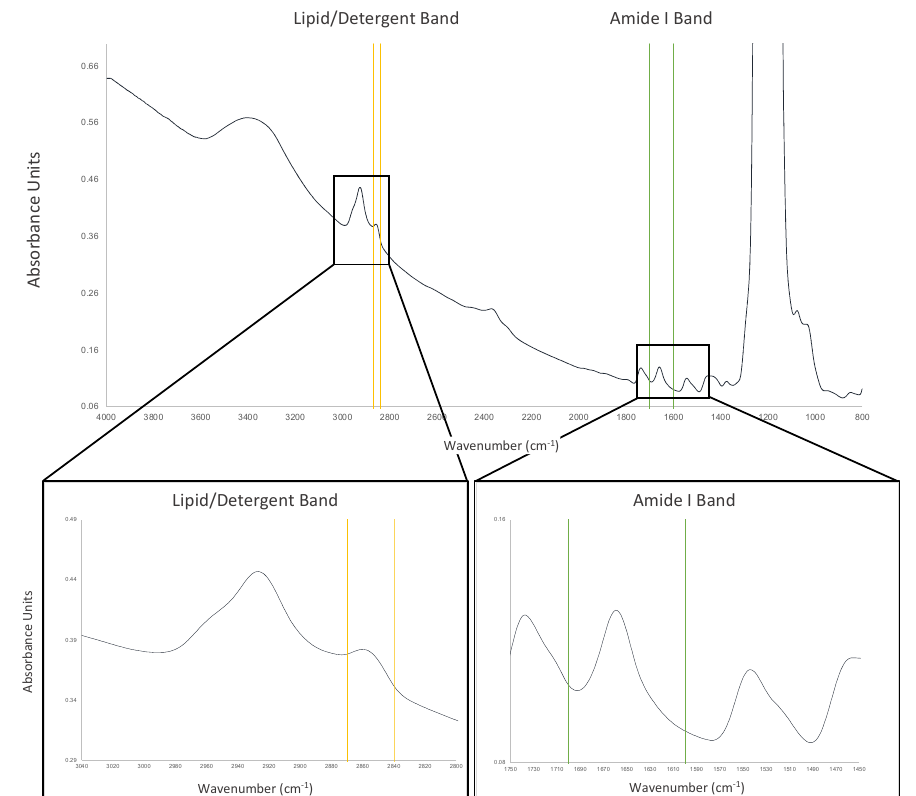
Figure 9. Mid-infrared spectrum of a membrane protein in n-Dodecyl- β - d -Maltopyranoside (DDM). Measurements were performed using the direct detect spectrometer (EMD Millipore). The protein sample (2 µ L) was blotted onto a hydrophilic polytetrafluoroethylene (PTFE) membrane and dried for 30 s using the built-in heater / fan system before measuring the MIR spectrum. The spectrum is plotted against the inverse of the wavelength (the wavenumber). Yellow represents the aliphatic C–H stretching region of DDM between 2870 and 2840 cm − 1 . Green represents the amide I region between 1700 and 1600 cm − 1 . Note the strong signal between 1300 and 1100 cm − 1 due to the PTFE membrane [121].